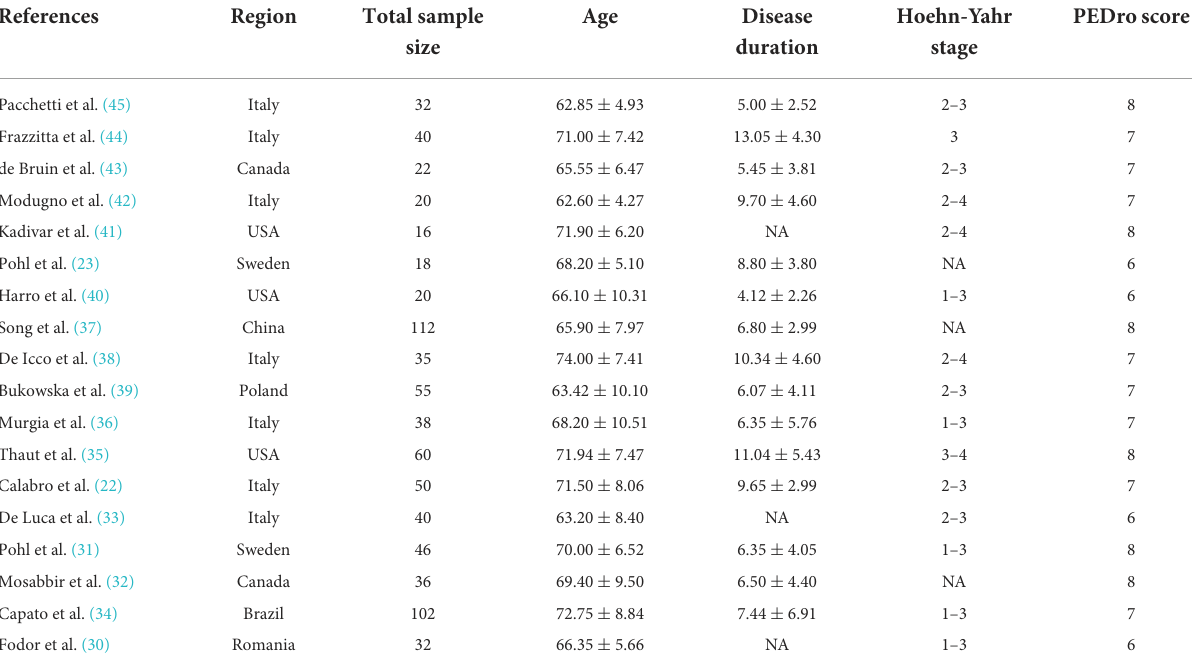
TABLE 1 Main characteristics of the studies included in the